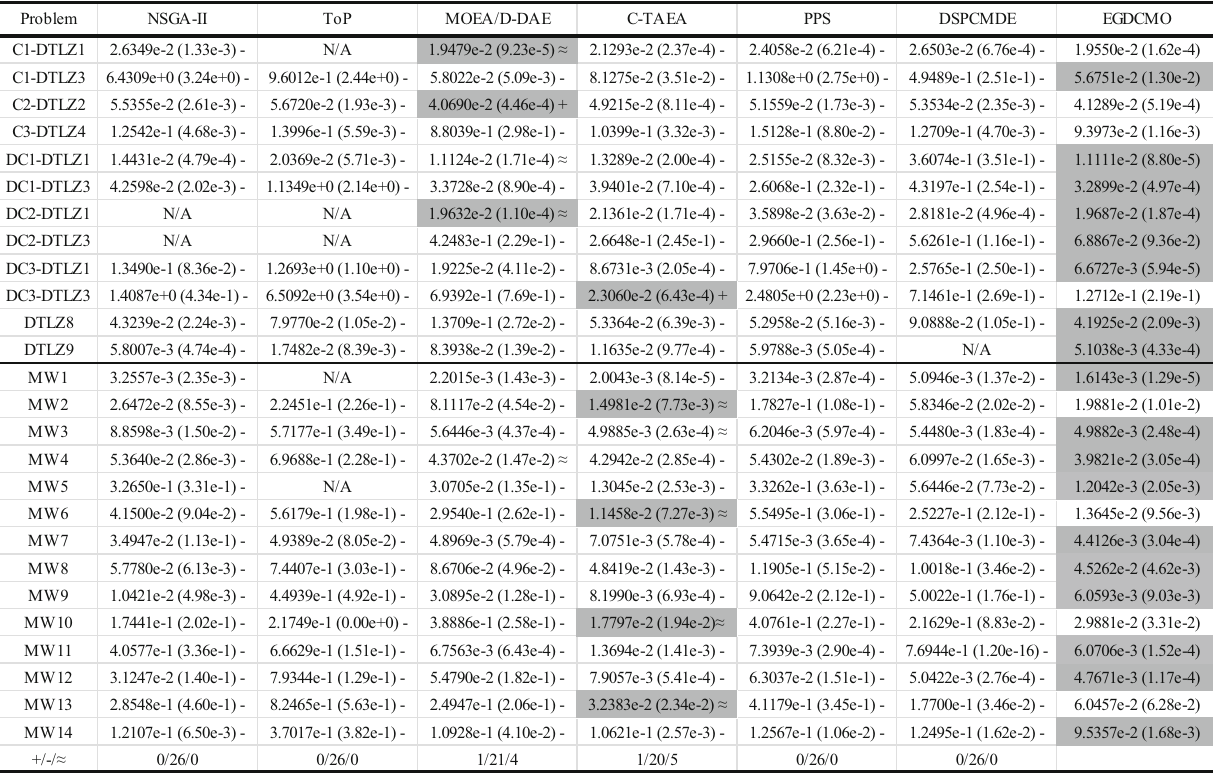
The best result in each row is highlighted. “N/A” indicates that no feasible solution is